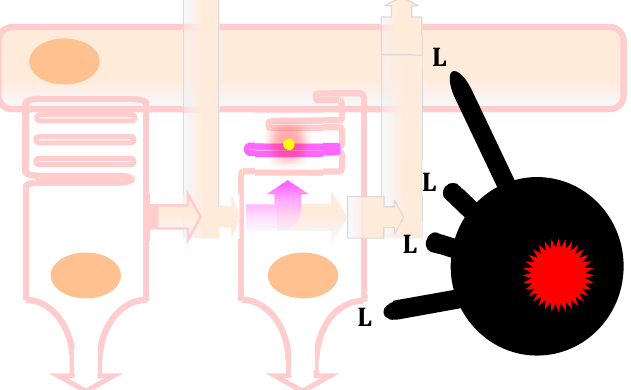
Figure 3. Blood-derived inflammatory macrophage perturbation of the metabolic ecosystem between photoreceptors and the retinal pigmented epithelium. In non-pathological conditions, the rod on the left produces and secretes the truncated thioredoxin rod-derived cone viability factor (RdCVF, pink arrow toward the right). The cone on the right expresses the RdCVF cell-surface receptor basigin-1 (BSG1). RdCVF activates the complex formed between BSG1 and the glucose transporter GLUT1 (SLC2A1) resulting in an acceleration of the entry of glucose coming from the blood circulation through the retinal pigmented epithelium (RPE, on the top). The cone metabolizes glucose through aerobic glycolysis that produces glycerol-3-phosphate as a precursor of the hydrophilic head of the phospholipids (dark pink) for the renewal of the cone outer segment that contains the light-sensing molecule, the opsin (yellow). Aerobic glycolysis also produces lactate that is transported outside the cone by a lactate (lac) transporter. The lactate is partially transported through the RPE toward the blood circulation via two lactate transporters; the one on the basal side (on the top) is encoded by the SLC16A8 gene that carries risk alleles for AMD. A certain proportion of the transported lactate is metabolized by the RPE to pyruvate that fuels the mitochondrial oxidative phosphorylation. In that ecosystem, the glucose issued from the blood circulation is not metabolized by the RPE. In pathological conditions, as in patients carrying SLC16A8 risk alleles for AMD, the accumulation of lactate and its metabolism by the mitochondrial respiratory chain produces an excess of reactive oxygen species by leakage, and since lactate transporters are facilitating transporters, the rise in lactate in the RPE triggers an elevation of lactate in the extracellular space between photoreceptors. For the same mechanistic reason, an excess of lactate outside the cone counteracts the intracellular glycolytic flux and inhibits aerobic glycolysis, resulting in the shortening of the cone outer segment and the impairment of cone vision of the macula. This AMD pathological mechanism, identified through genome-wide association studies, may represent a genetic signature of a role of lactate produced after the metabolism reprogramming of inflammatory macrophages occurring in the disease due to chronic inflammation. This is illustrated by the infiltrated inflammatory macrophage (black, on the far right) which produces lactate and elevates the concentration of lactate in the retina, as does the SLC16A8 risk alleles.